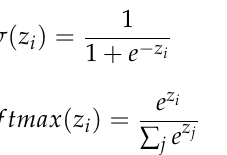
Table 5. Various performance values for each experiment. Standard deviation for all ROC – AUC scores was less than 0.01.